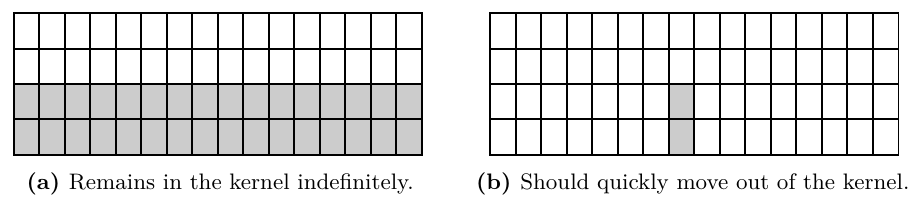
Figure 1: Examples of state patterns in the